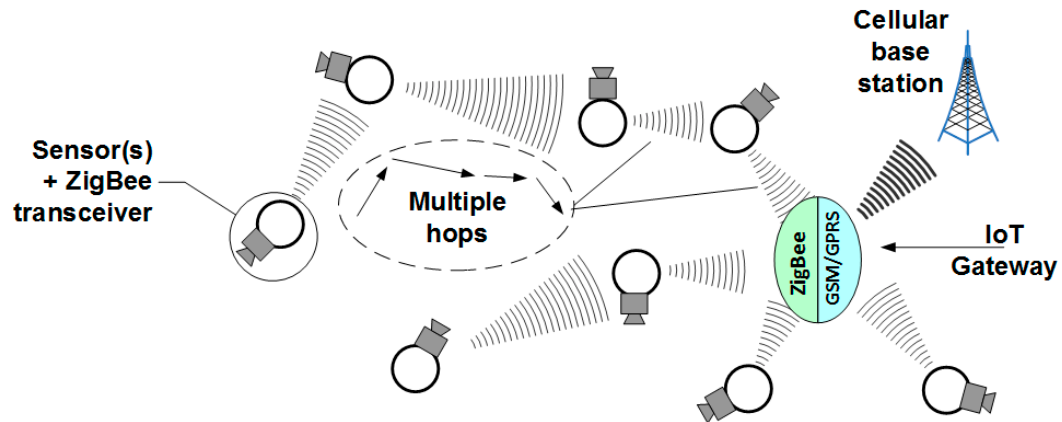
Figure 2. The local segment with multi-hop transmissions between sensor modules prior to reaching the IoT Gateway.